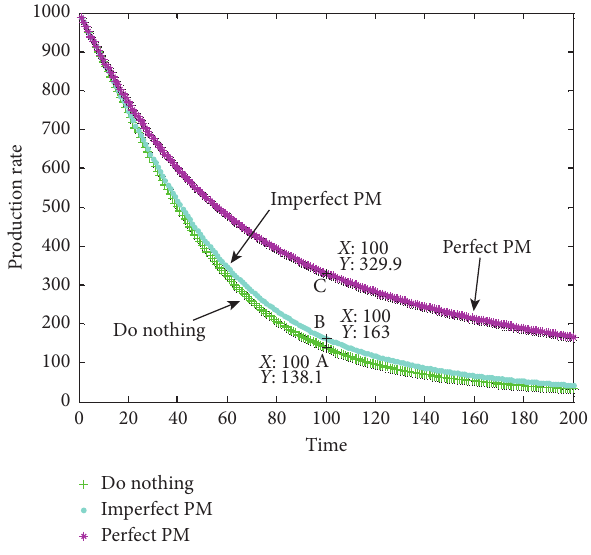
Figure 9: The curves of ρ ( t ) on three actions.